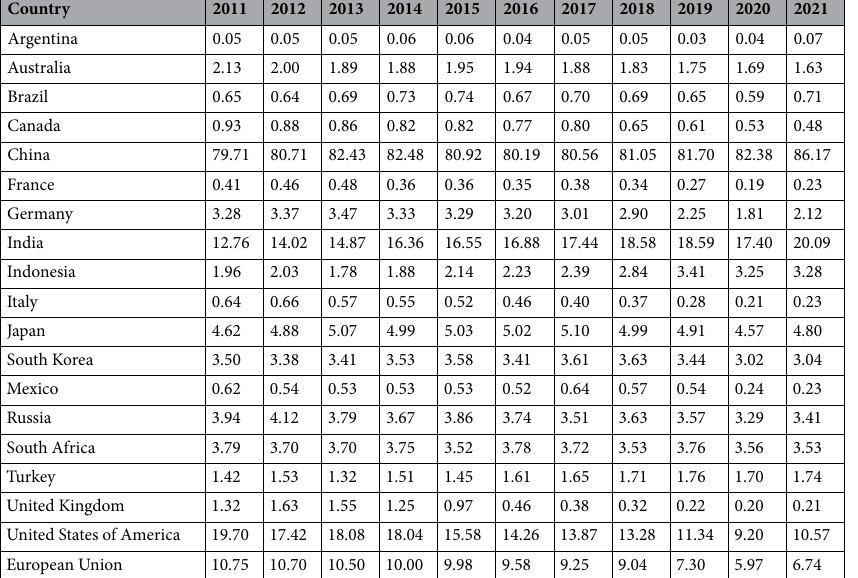
Table 8. Coal consumption data of G20 countries 47 . All consumption in